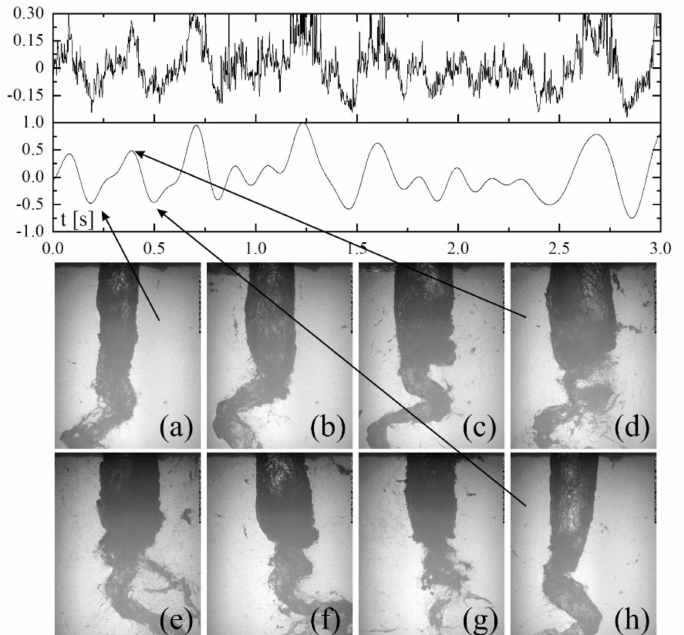
Figure 6. Time evolution of vortex volume oscillation. Condition 5 ( n = 910 r/min and Q = 0.031 m 3 /s). ( a – h ) indicate different vortex stages during one oscillation